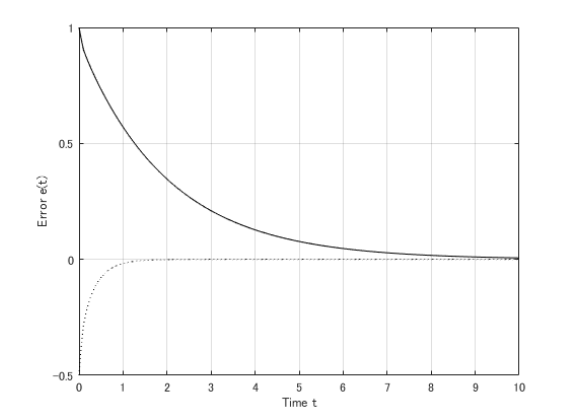
Figure 1. The error